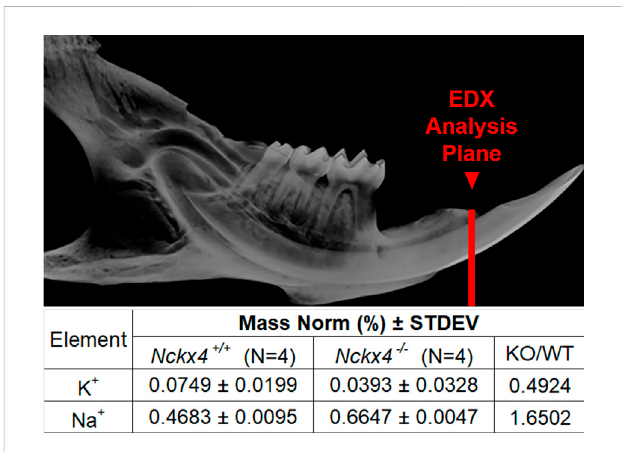
FIGURE 1 EDX analysis of Nckx4 +/+ and Nckx4 − / − enamel. A red line drawn on amicroCTimageofamousemandibularhemimandibleshowstheplane of section analyzed by EDX. The mass norm % of K + was decreased and Na + increased in the Nckx4 − / − enamel matrix relative to the Nckx4 +/+